Question: In a single sentence, describe what this figure presents.
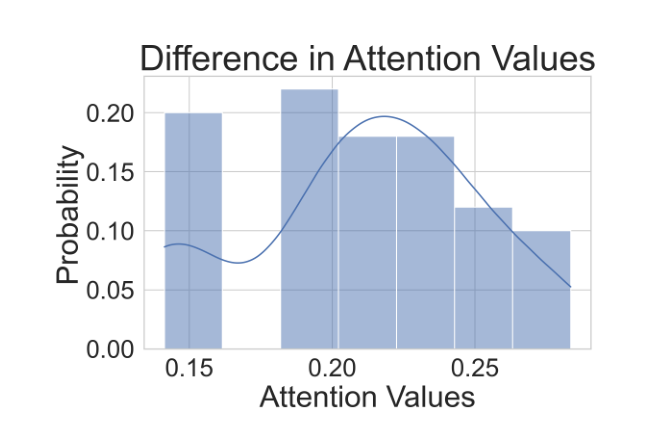
Answer: Differences in attention between layers of best reward and layers with negative reward